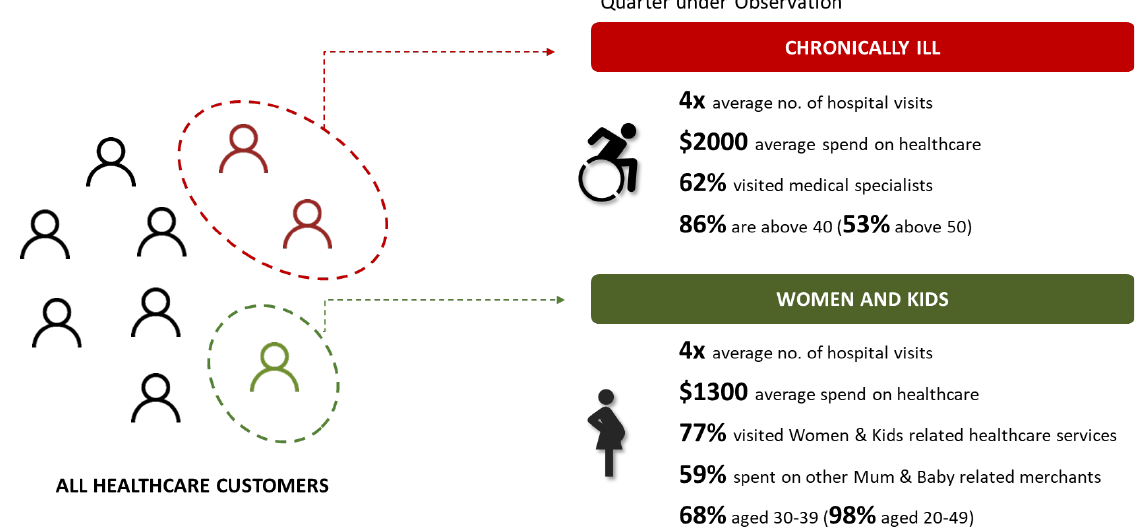
Figure 13. Identifying customers with distinct needs for bespoke solutions.